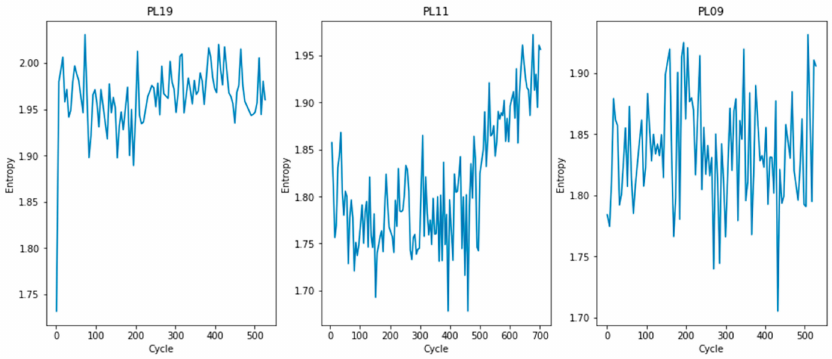
Figure 6. Entropy vs. Cycles for PL11, PL19, and PL09.